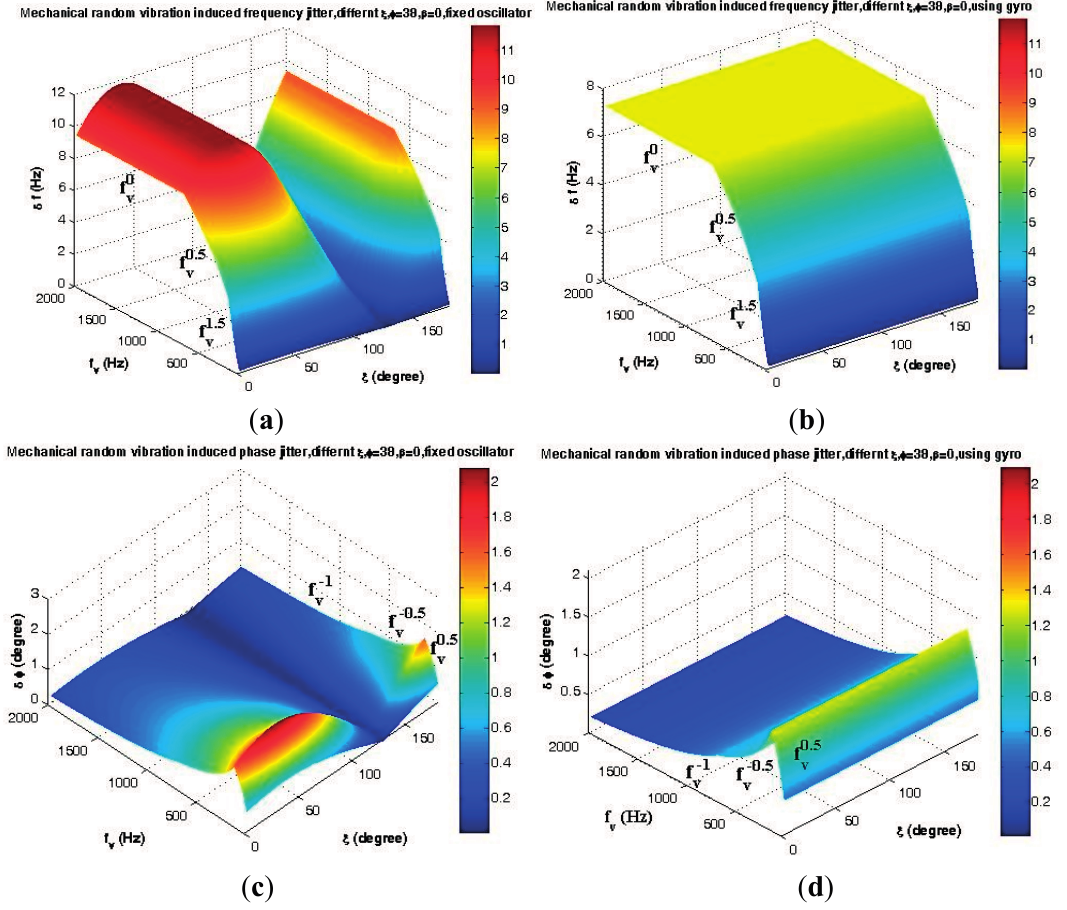
Figure 21. Analysis of the mechanical random vibration in the frequency domain for β = 0, | φ | = 38°. ( a ) Frequency jitter of a fixed oscillator; ( b ) Frequency jitter of the gyroscopic mounting; ( c ) Phase jitter of a fixed oscillator; ( d ) Phase jitter of the gyroscopic